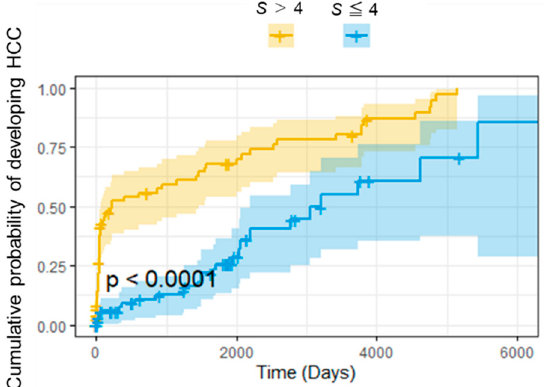
Figure 5. Survival curves for subjects with S of more than 4 and with S of less than or equal to 4. p value in the plot was calculated by log-rank